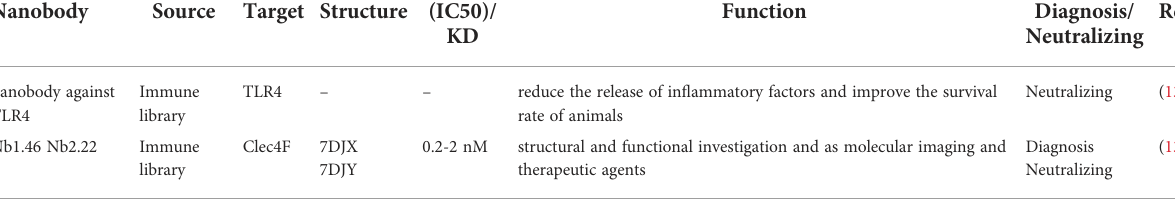
TABLE 4 Single Domain Antibody against Pattern Recognition